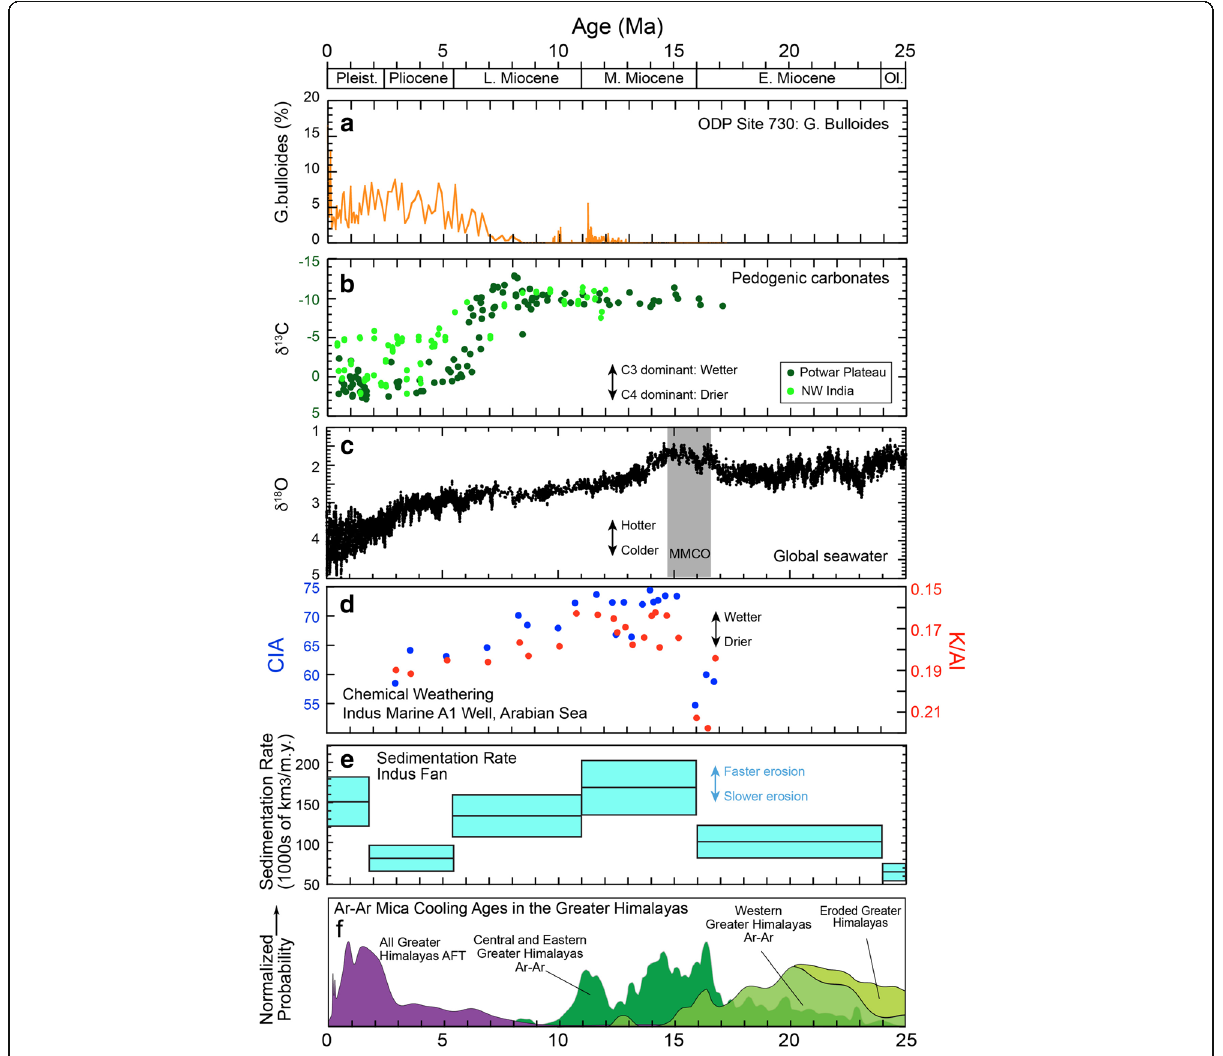
Fig. 12 Comparison of climate, erosion and exhumation proxies in the Himalaya. a Abundance of G. bulloides at ODP Site 730 on the Oman margin as a proxy for summer monsoon wind strength (Gupta et al. 2015). b Carbon isotope character of pedogenic carbonate in Pakistan as an indicator of dominant vegetation in the Potwar Plateau of Pakistan (Quade et al. 1989), and NW India (Singh et al. 2011). c Global d18O as a proxy for seawater temperatures and/or ice volume from Zachos et al. (2001). d Degree of chemical alteration of sediments on the Indus continental shelf at Indus Marine A-1 as measured by K/Al and CIA (Clift et al. 2008), e Rates of sediment supply to the Arabian Sea calculated from regional seismic (Clift 2006). f Exhumation rates of the Greater Himalaya tracked by bedrock Ar-Ar dating (Clift et al. 2008) and foreland basin sediment (Szulc et al.